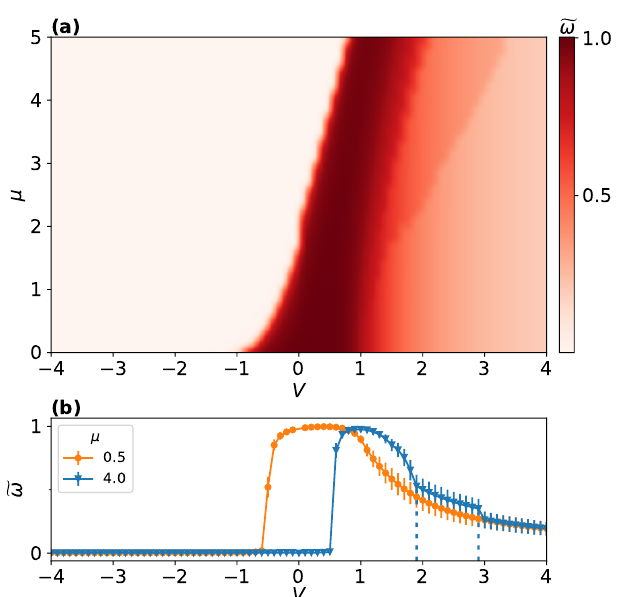
ω of the phase diagram Figure 9: Convolutional neural networks. (a) Predictions (cid:101) of the interacting Hamiltonian carried out by means of the CNN ensemble. The topo- logical phase is correctly predicted (dark red region). (b) Two cuts of the phase ω and their relative standard errors as a function diagram showing the predictions (cid:101) of V for different µ . For the points with µ ≳ 1 in the CDW phase it is possible to see the appearance of discontinuities (indicated by dashed vertical lines) for the values ω that correspond to the onset of the incommensurate CDW (cid:101)